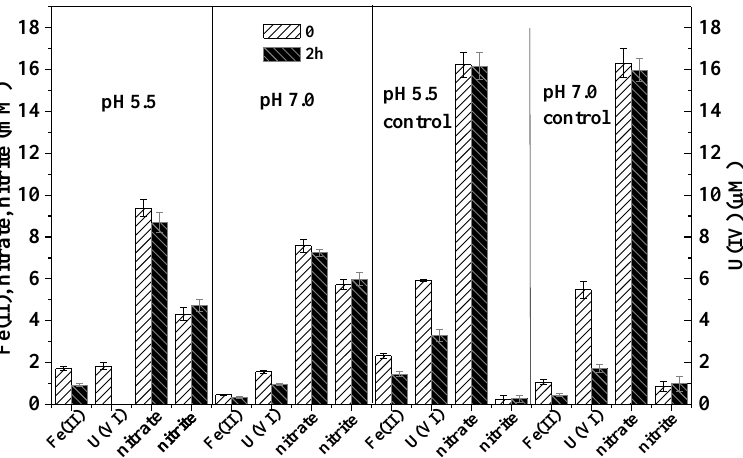
Figure 3. Changes in concentrations of Fe(II), U(VI), nitrate, and nitrite after oxidation for 2 h following 96 h of anaerobic incubation. Data shown are means ± SD ( n =